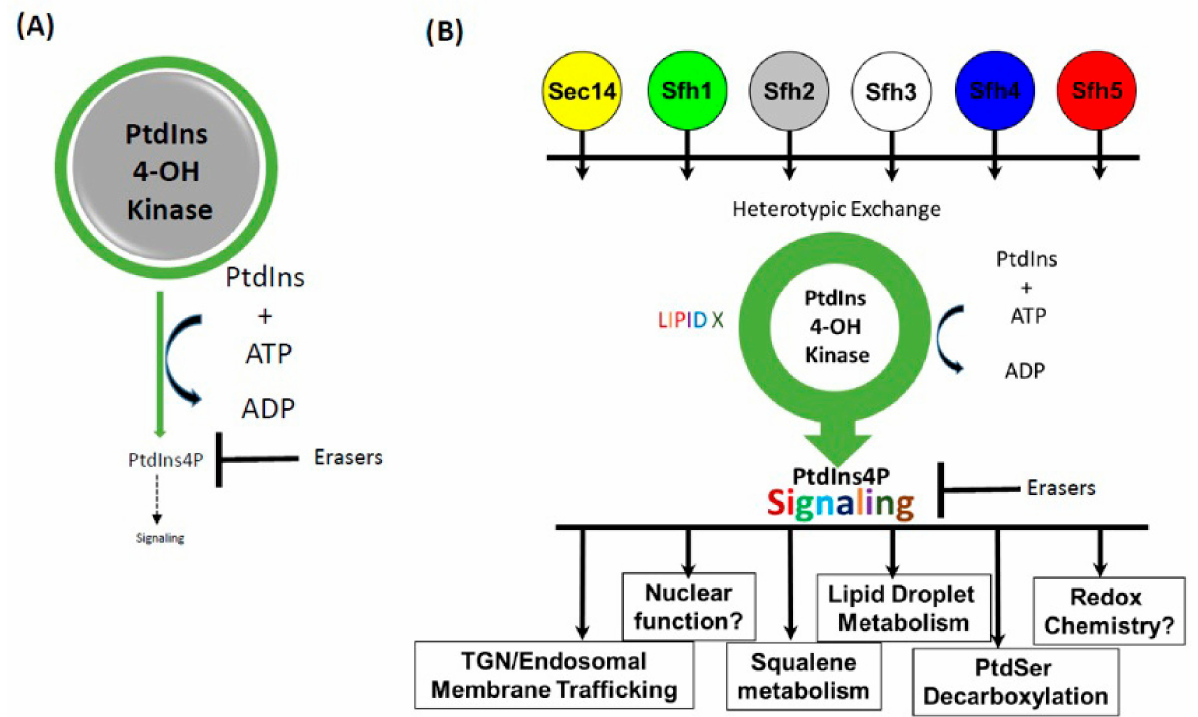
Figure 4. PITPs as novel portals for surgical intervention with specific channels of PtdIns(4)P-signaling. ( A ) PtdIns 4-OH kinases are intrinsically inefficient enzymes in physiological settings. These enzymes are incapable of generating sufficient PtdIns(4)P to overcome the activities of antagonists (erasers) of PtdIns(4)P signaling (e.g., phosphoinositide phosphatases). ( B ) Sec14-like PITPs potentiate PtdIns 4-OH kinase activities so that these enzymes produce sufficient PtdIns(4)P for signaling in a temporally and spatially regulated manner. Sec14-like PITPs specify metabolic inputs into production of unique PtdIns(4)P pools that promote unique biological outcomes. These are proposed to do so by engaging in transient complexes where an individual PITP interacts with a PtdIns 4-OH kinase in the context of a specific set of PtdIns(4)P effectors, assembled either as individual proteins or in PITP multidomain arrangements. The identity of the PITP in the complex specifies the metabolic input in the form of the second ligand they bind for priming PtdIns presentation to the PtdIns 4-OH kinase, and the cohort of proximal PtdIns4P effectors determines biological